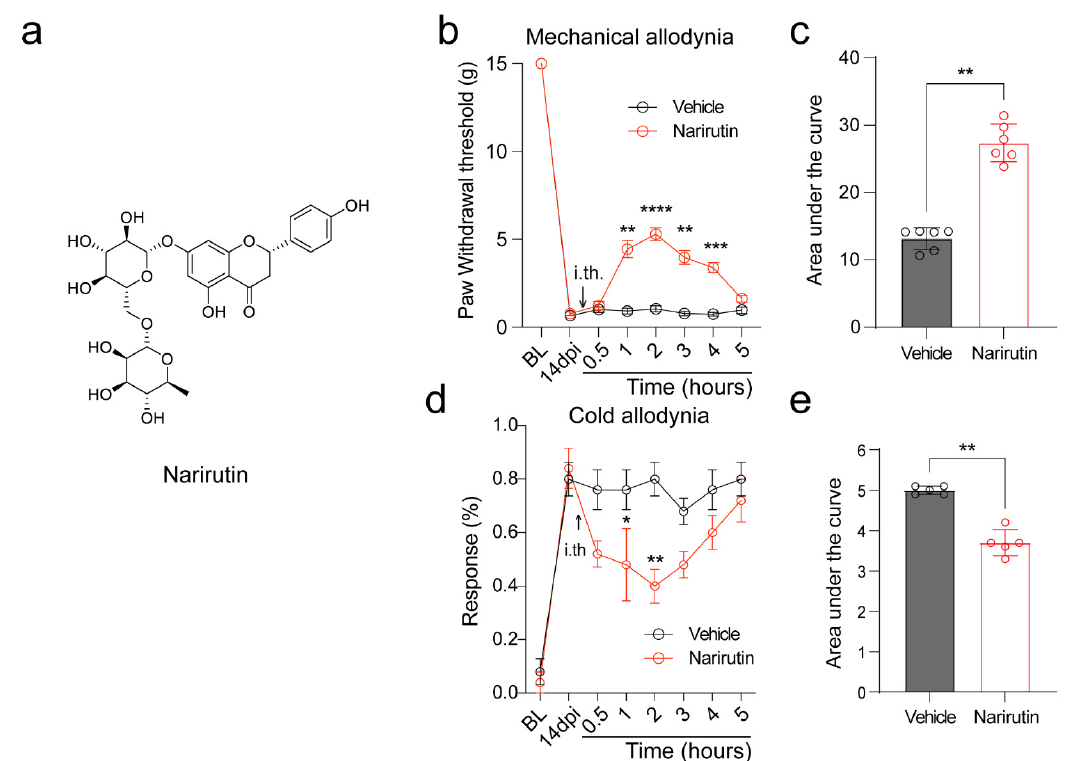
Figure 1. Narirutin alleviates SNI-induced mechanical allodynia. ( a ) Chemical structure of Narirutin. (National Center for Biotechnology Information (2022). PubChem Compound Summary for CID 442431, Narirutin. Retrieved 22 September 2022, from https://pubchem.ncbi.nlm.nih.gov/com- pound/Narirutin.) ( b ) The Paw withdrawal threshold (PWT) and ( d ) acetone noxious withdrawal responses of adult male rats ( n = 6) were measured at 14 dpi. Rats were treated intrathecally (i.th., black arrow) via a catheter with vehicle (10% DMSO, 10% Tween-80, 80% Saline, 20 μ L) or Narirutin (20 μ g/20 μ L) as indicated. Area under the curve for ( c ) mechanical and ( e ) cold allodynia was derived again as indicated before using Graphpad Prism. Data are expressed as means ± SEM. Asterisks indicate statistical significance compared with vehicle treatment (* p < 0.05, ** p < 0.01, *** p < 0.001, and **** p < 0.0001; two-way ANOVA with Sidak’s post hoc test). The experimenter